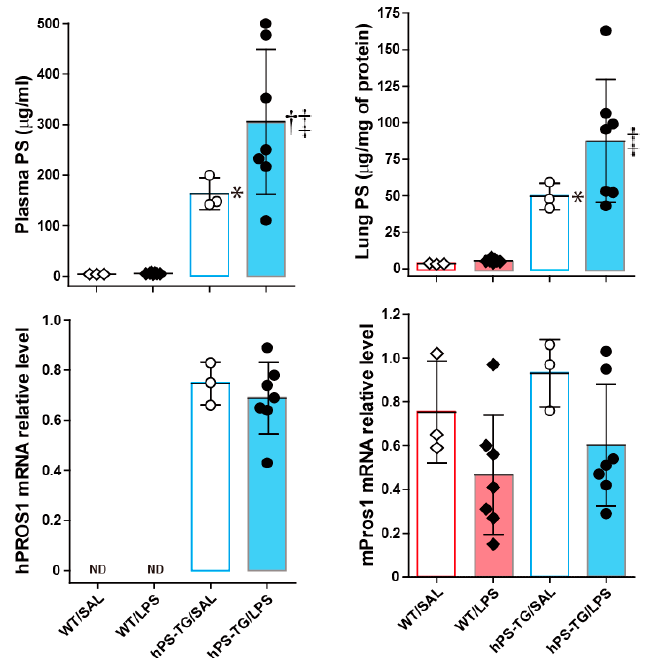
Figure 1. Systemic and local upregulation of Protein S (PS) during lipopolysaccharide (LPS)-induced acute lung injury (ALI). Mice were allocated in four groups including wild type mice treated with saline (WT/SAL, n = 3) or LPS (WT/LPS, n = 7), and human PS transgenic (TG) mice treated with saline (hPS TG/SAL, n = 3) or LPS (hPS TG/LPS, n = 7). The level of PS was measured by enzyme immunoassay and the gene expression by reverse transcription polymerase chain reaction (RT-PCR). Data are expressed as the mean ± SD. * p < 0.05: hPS-TG/SAL vs WT/SAL; † p < 0.05: hPS-TG/LPS vs hPS-TG/SAL; ‡ p < 0.05: hPS-TG/LPS vs WT/LPS. ND, not detected.